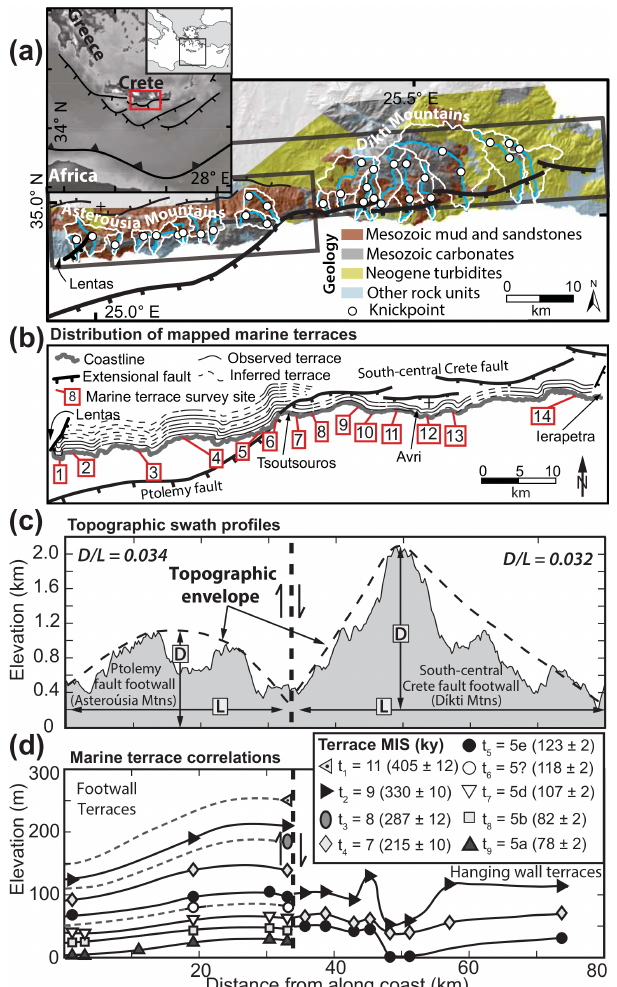
Figure 1. Inset maps show the location of the study area in south-central Crete and generalized tectonic setting. (a) Digitized 1:50000 scale geologic maps (Greek Institute of Geology and Min- eral Exploration, 1972; 1974; 1977; 1987) with the outlines of the 21 drainage basins in thin white lines and trunk river channels in light blue. The dark gray rectangles show the locations of the eleva- tion profiles shown in panel. (c) Active normal faults are shown as black lines with the hatch marks on the hanging wall after Gallen et al. (2014). (b) Map of the south-central coastline of Crete with the geographic distribution of Pleistocene marine terraces. The figures are not drafted to scale, such that the vertical separation between terraces is relative. Sites 1–14 are the marine terrace survey sites from Gallen et al. (2014). The locations of some of the major towns and faults are shown. (c) Maximum topography of south-central Crete as determined by swath profiles taken along the Asteroúsia and Díkti mountains (see Fig. 1a for location). Dashed lines indicate the profile of maximum displacement as determined by correlation of the highest peaks in the respective fault blocks. The thick ver- tical dashed line indicates the location and sense of motion for an active extensional fault, the South-Central Crete fault. (d) Terrace correlations for the south–central coastline of Crete (Gallen et al.,